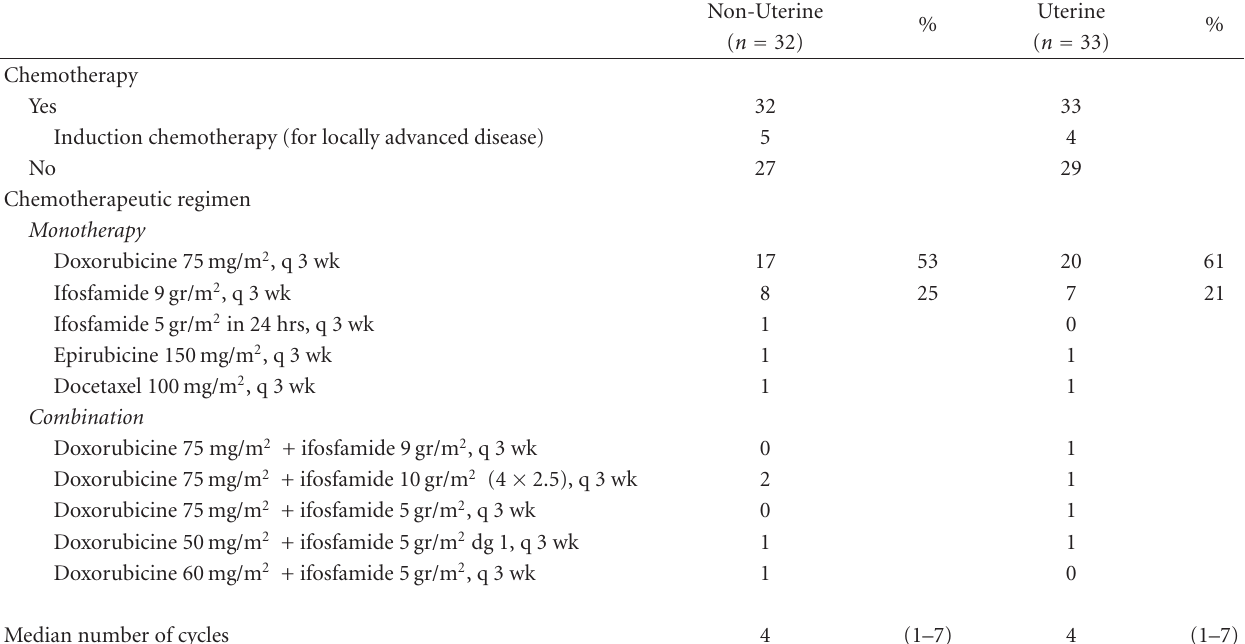
Table 2: Treatment